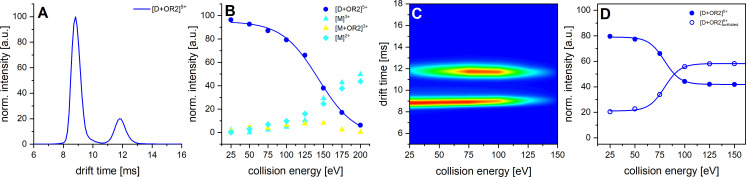
CID and CIU experiments of Aβ42 with OR2.A shows the IM spectrum of the 5-times charged dimer of OR2 bound Aβ42. The signal of the folded and unfolded MB species are visible, while no signal can be observed for a DB conformation. B shows the observed CID in dependence of CE increase. C depicts a heat map of the CIU experiment of the 5-times charged dimer peak of OR2 bound Aβ42. D shows an intensity plot of the peaks visible in the CIU experiment of B.